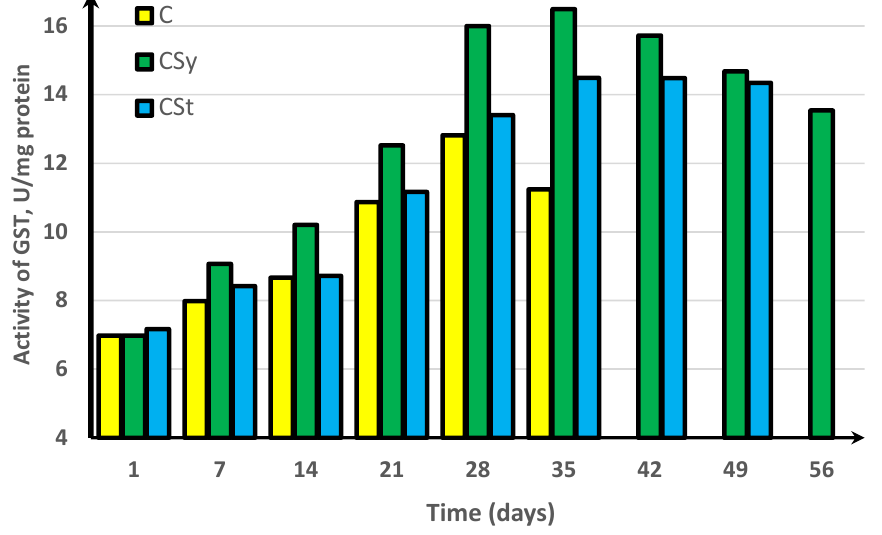
Figure 2. Glutathione S-transferase (GST) activities in workers’ hemolymph along with the aging processes, after using two methods of supplementation with hemp extract. C, control (pure sugar syrup); CSy, hemp extract in syrup; CSt, hemp extract on strips (two-way ANOVA: supplementation method: F (5,1078) = 40,402, p = 0.0000, se ± 0.010431 (C), se ± 0.008517 (CSy), and se ± 0.009657 (CSt); days of supplementation: F (5,1078) = 40,402, p = 0.0000, se ± 0.014751 (1st–35th days), se ± 0.025550 (42nd day and 56th day), and se ± 0.018066 (49th day); supplementation method × days of supplementation F (11,1078) = 1416.0, p = 0.0000, and se ± 0.025550). The chart shows statistical averages. The standard deviations for the means in this plot ranged from 0.04158 to